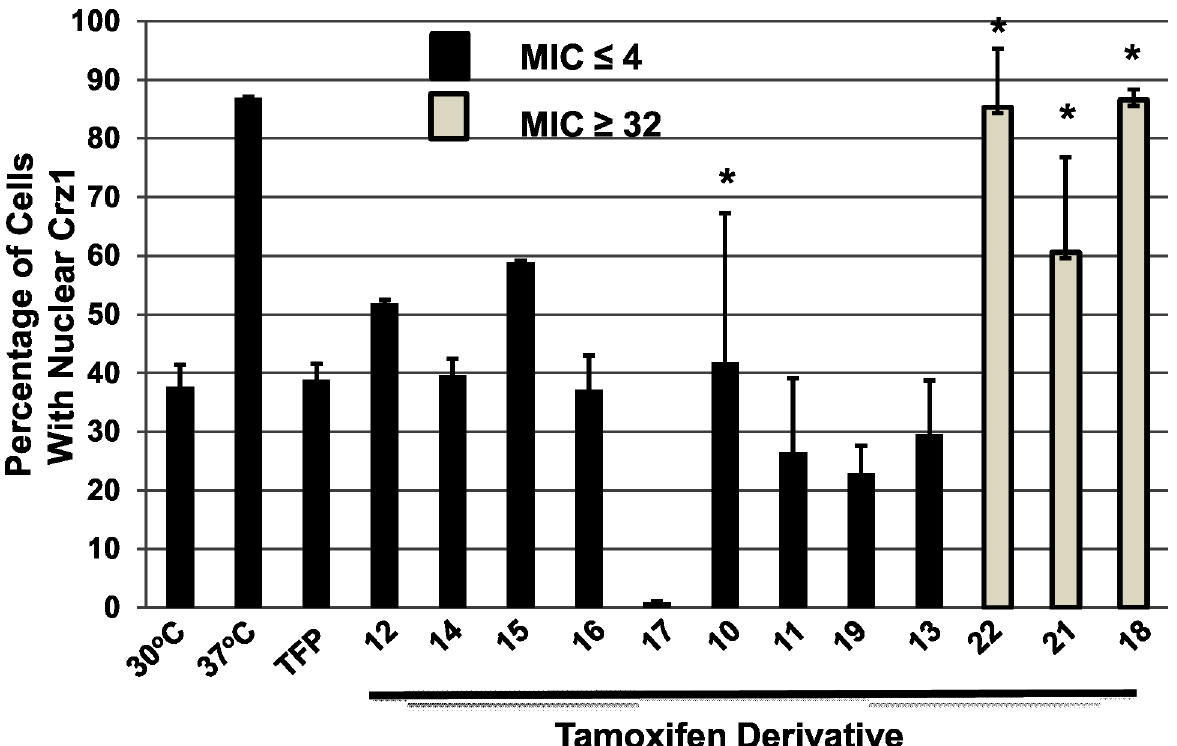
Fig 5. Effect of tamoxifen-derivatives on the temperature-induced, calmodulin-dependent nuclear localization of the transcription factor Crz1. As described in the materials and methods, C . neoformans cells harboring Crz1-mCherry and the nuclear marker Nop1-GFP were shifted to 37°C in the presence or absence of the indicated tamoxifen derivative (see Figs 2 – 4 for structures corresponding to the molecule numbers) at ¼ of minimum inhibitory concentration (MIC). The percentage of cells with co-localized mCherry and GFP signals was determined for a minimum of 100 cells with at least two independent biological samples. The bars indicate mean percentage of cells with nuclear Crz1 and error bars indicate standard deviation. All compounds except those with an asterisk ( * ) above the bar gave values that were significantly different than the untreated control (P < 0.05, Student ’ s unpaired, two-tailed t test). MIC values are taken from data in Figs 2 –